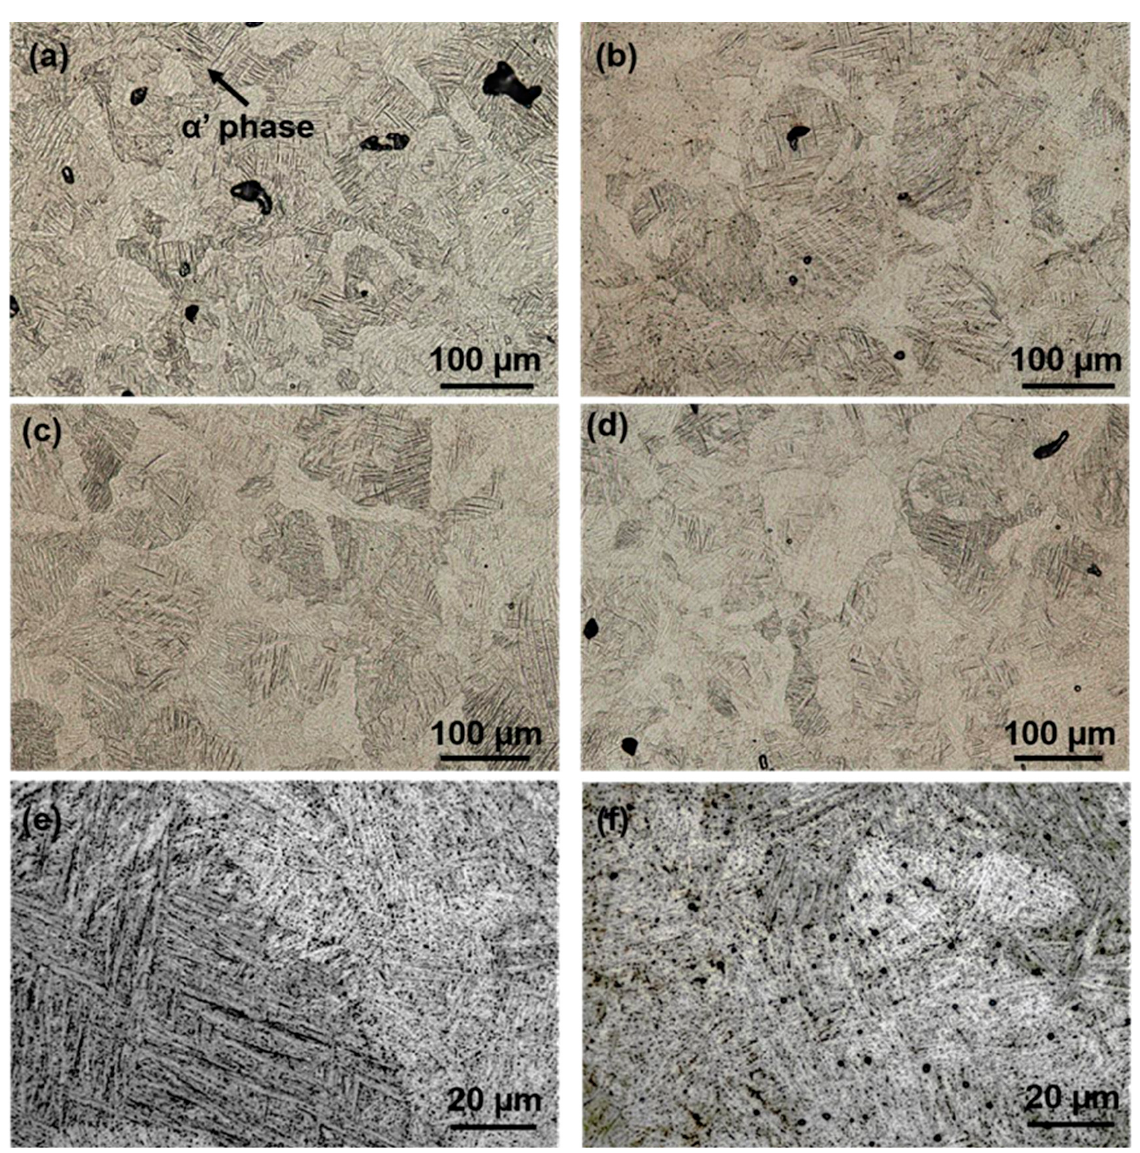
Figure 2. Metallographs of Ti6Al4V alloy prepared with the process parameter of ( a ) v = 1200 mm/s, P = 160 W, ( b ) v = 1200 mm/s, P = 280 W, ( c ) v = 1000 mm/s, P = 200 W, ( d ) v = 1400 mm/s, P = 200 W, and SEM micrographs of the Ti6Al4V alloy prepared with the process parameter of ( e ) v = 1000 mm/s, P = 200 W, and ( f ) v = 1400 mm/s, P = 200 W.